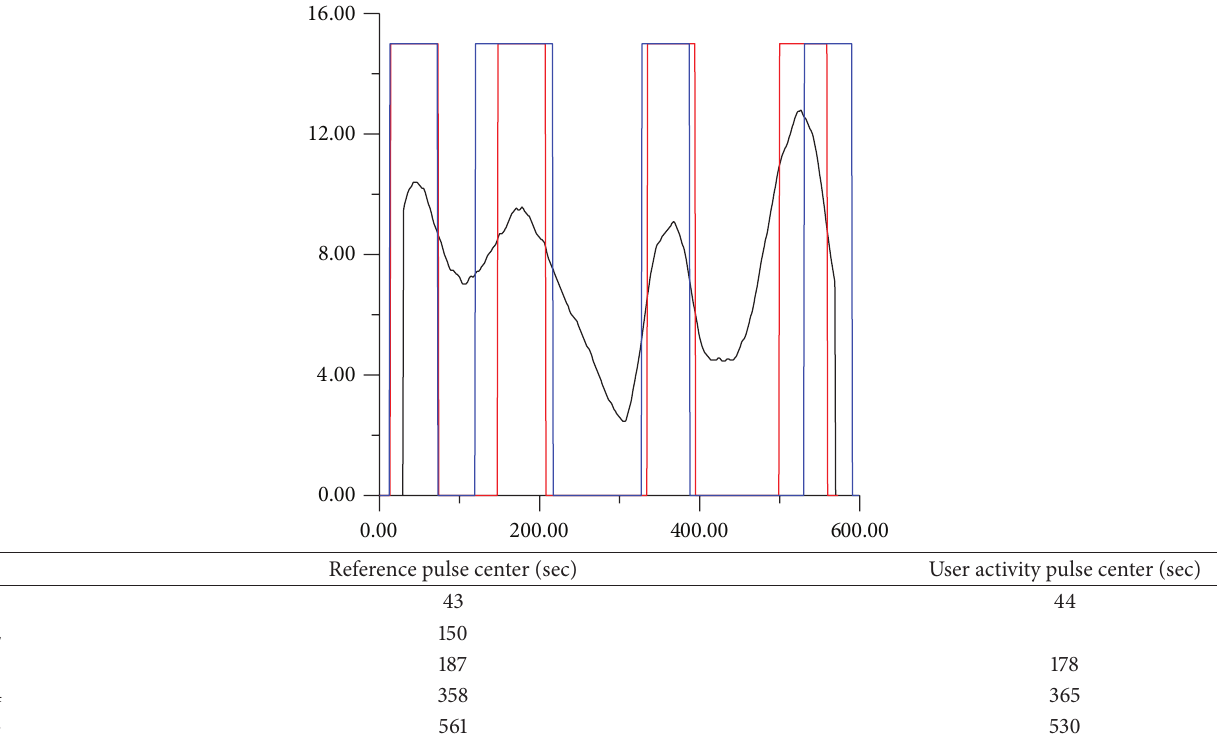
Table 2: Video A is a lecture video (http://www.youtube.com/watch?v=8LebAtvulIY). The pulse width 𝐷 is 60 seconds and the smoothing window 𝑇 is 60 seconds. The pulse modeling is reported with respect to the center of each pulse.